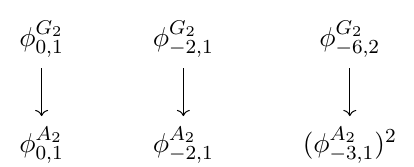
Figure 1 . The map between J ( G 2 ) and J ( A 2 ) generators. The vertical arrows denote equality.